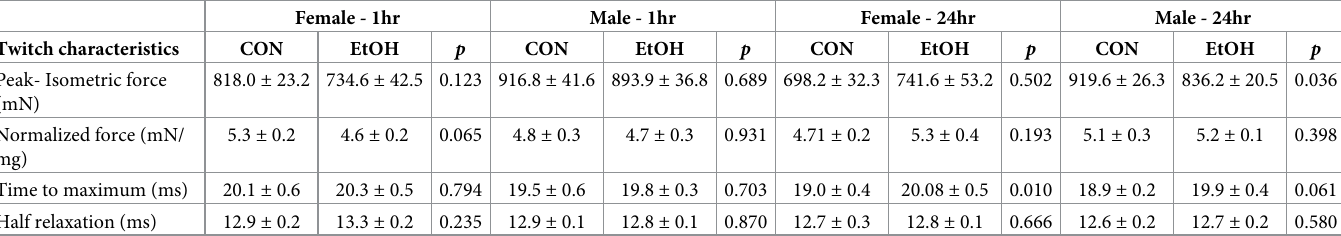
Table 1. Twitch characteristics for female and male mice 1 hour and 24 hours after acute alcohol intoxication.